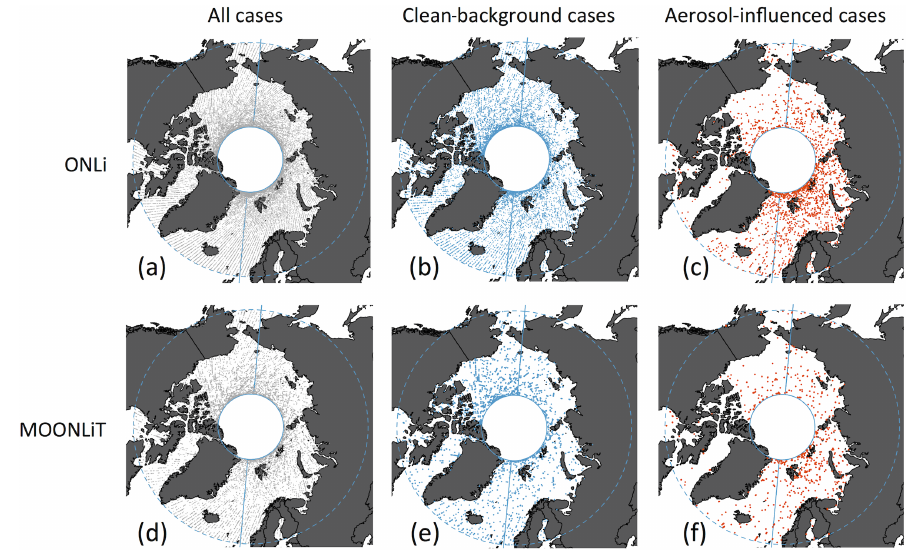
Figure 1. The geographical distribution of ONLi and MOONLiT cloud profiles, where (a, d) grey indicates all cases, (b, e) blue indicates clean background cases, and (c, f) red indicates aerosol-influenced